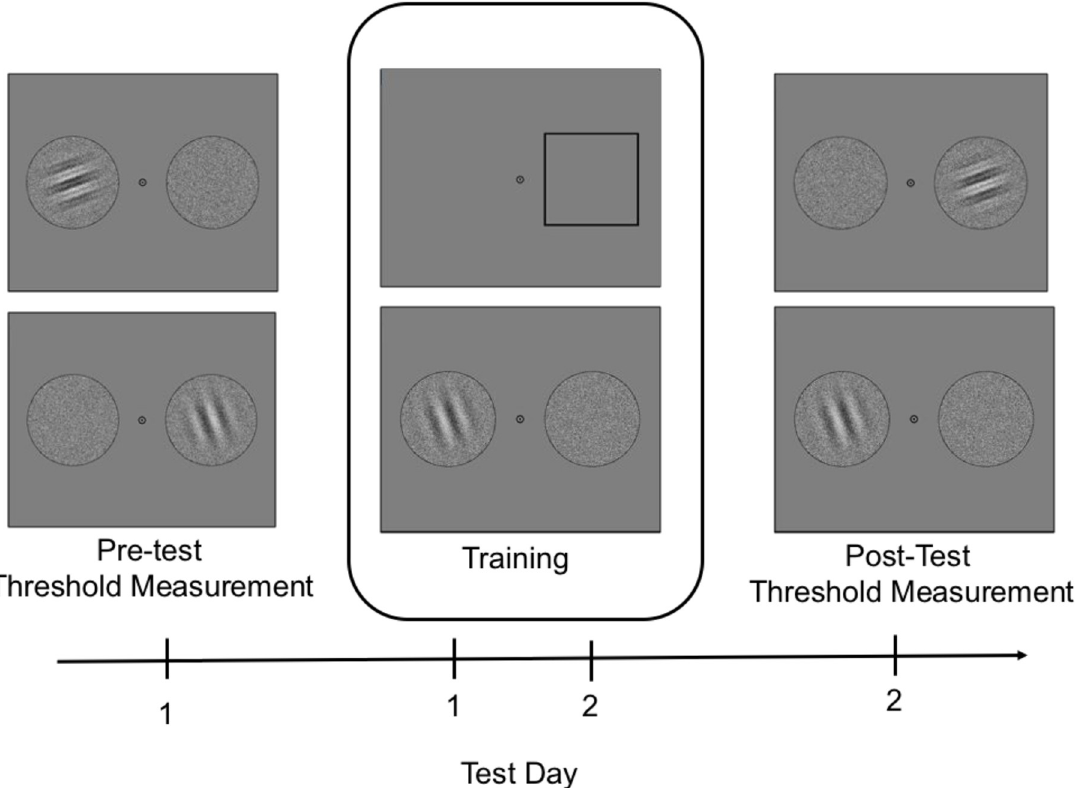
Fig 1. Time course of the experiment. Contrast thresholds for trained and untrained orientation were obtained at 75% correct. Training sessions occurred on day 1 and day 2 after pre-test and prior to post-test. Attention (exogenous, endogenous) and cue-validity (100%, 80%, neutral) were manipulated at